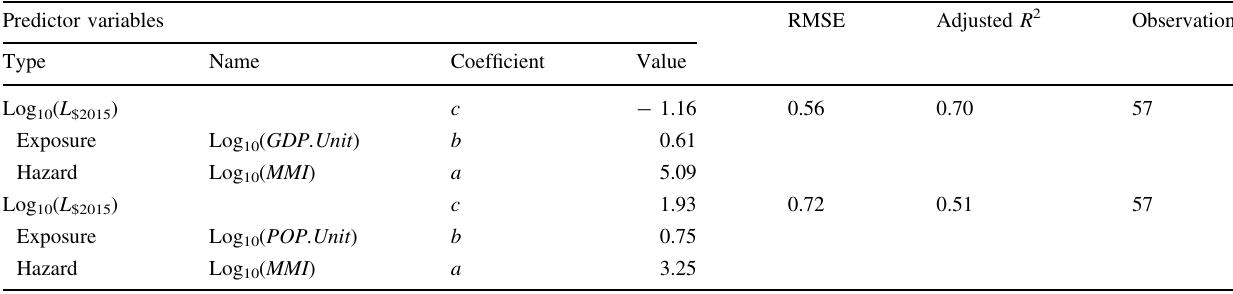
Table 6 Regression of the economic losses adjusted to 2015 USD value ( L $2015 ) considering intensity ( MMI ) as the hazard-related variable and GDP.Unit or POP.Unit as the exposure-related variable, and the coefficients of the regression models (Eq. 4) Predictor